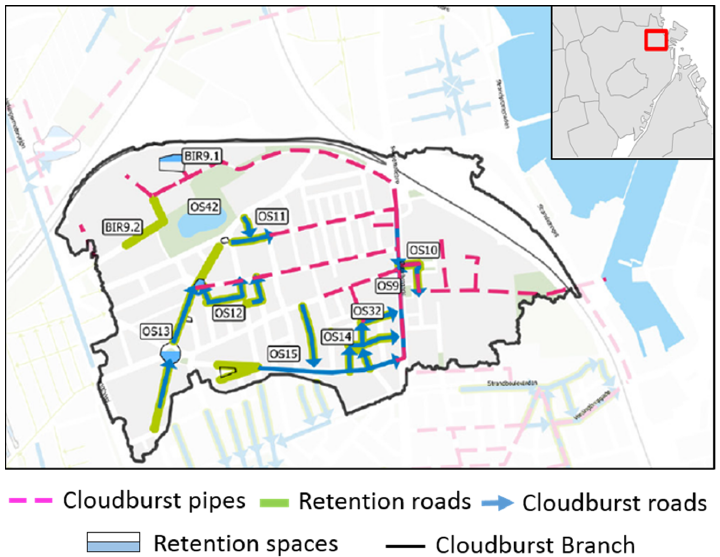
Figure 2. The cloudburst management solution for the cloudburst branch “Ydre Østerbro”, adapted from Reference [11].